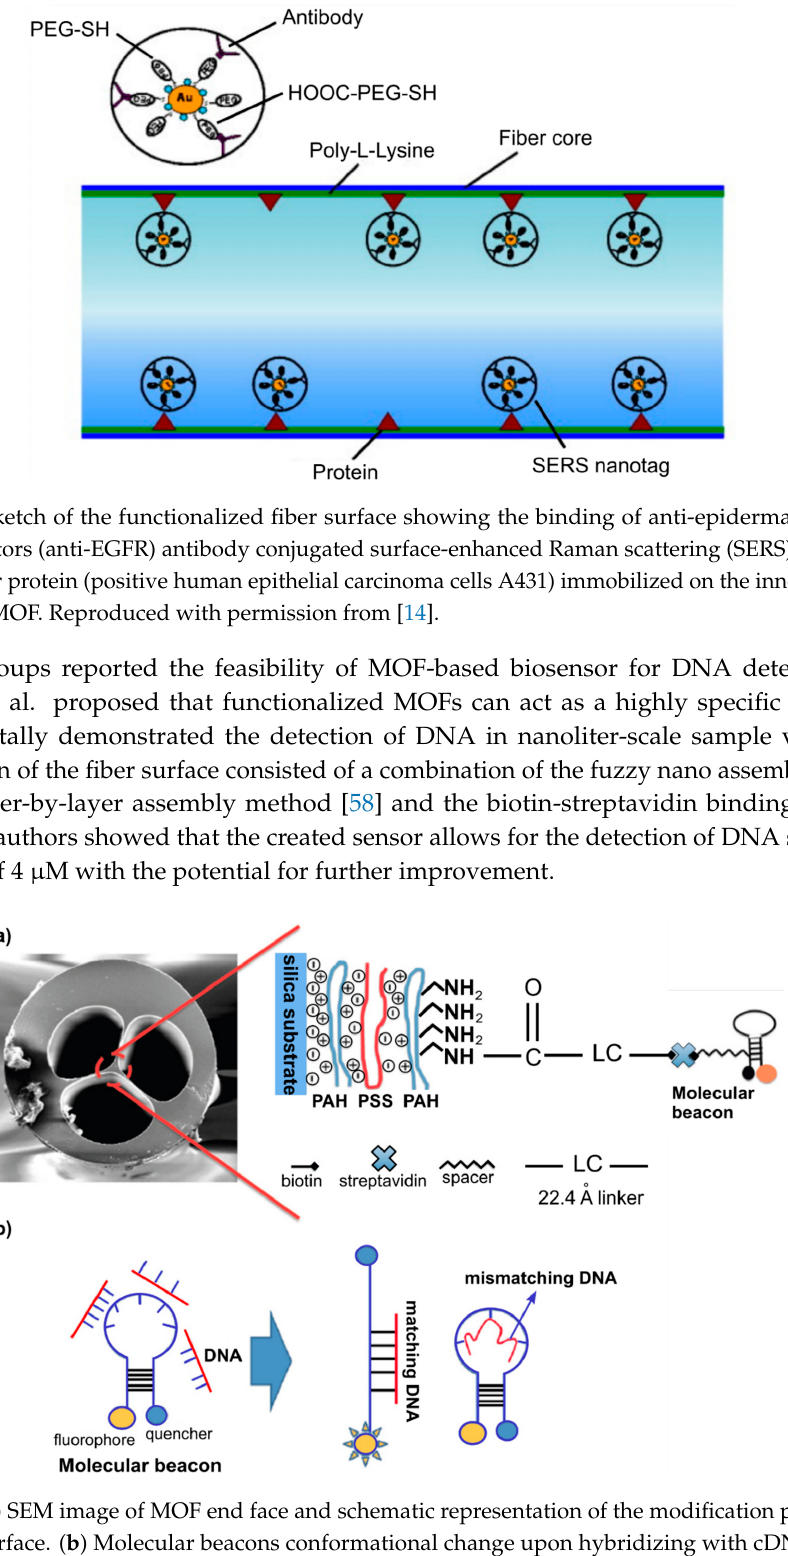
Figure 9. ( a ) SEM image of MOF end face and schematic representation of the modification process of the MOF surface. ( b ) Molecular beacons conformational change upon hybridizing with cDNA while remaining in closed form upon hybridizing with nDNA. Adapted with permission from [57]. © The Optical